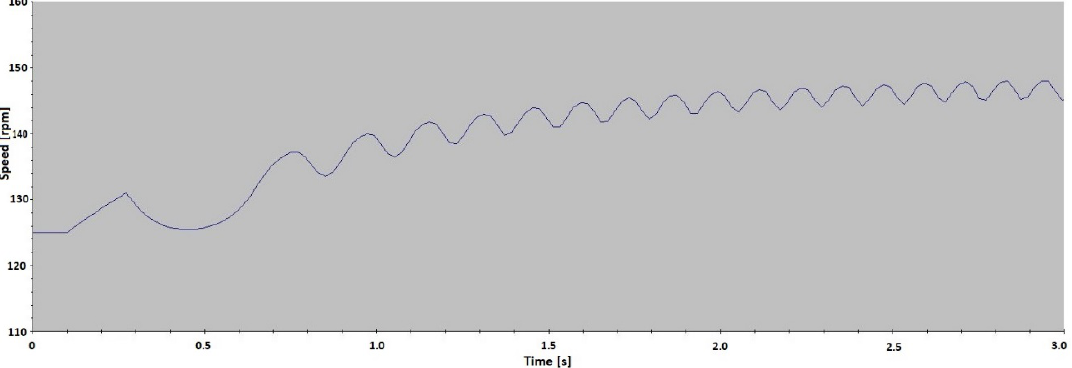
Figure 26. Simulation results of speed of Generator 2 during the three-phase fault with the fault duration of 172 ms.